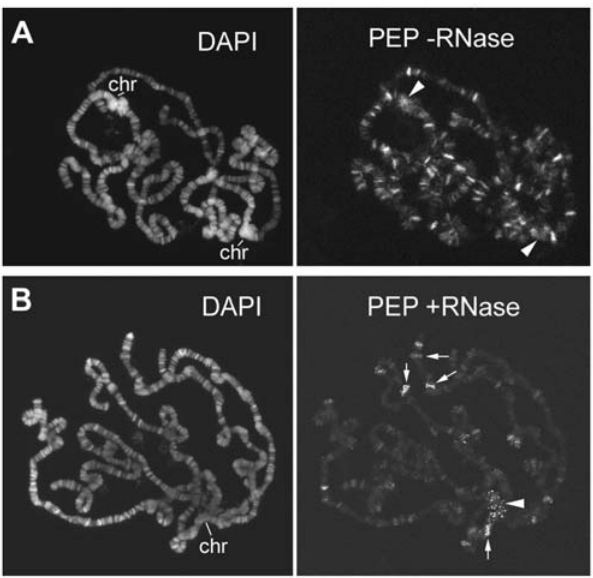
Figure 10. Modifications of PEP immunopattern on polytene chromosomes after RNase treatment. (A) PEP immunopattern on wild type polytene chromosomes. (B) PEP immunopattern on wild type polytene chromosomes after RNase treatment. Several immunosignals along euchromatin are removed while other immunosignals (arrows), including those on the chromocenter (arrowheads), become punctu- ated. Chr=chromocenter.